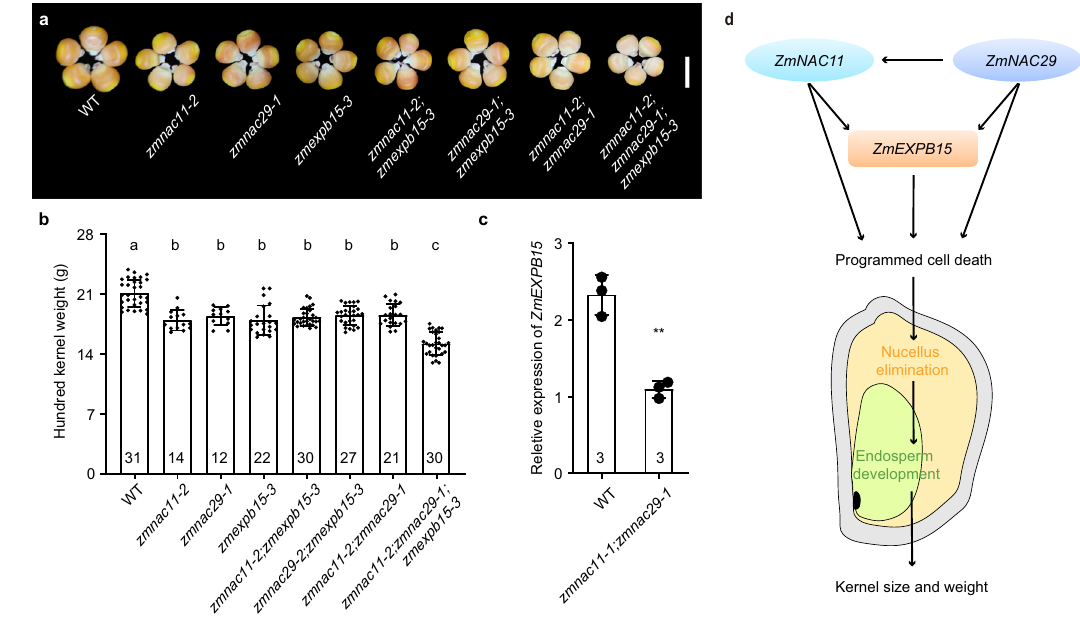
Fig. 7 | ZmEXPB15 may act in a common pathway with ZmNAC11 and ZmNAC29 to regulate kernel size and weight. a Comparison of the mature kernels of wild type(WT)anddifferentmutationcombinations, zmnac11-2 , zmnac29-1 , zmexpb15-3 (KO3), zmnac11-2;zmexpb15-3 , zmnac29-1;zmexpb15-3 , zmnac11-2;zmnac29-1 and zmnac11-2;zmnac29-1;zmexpb15-3 in C01 background. Scale bar=1cm. b QuantitativeanalysisofHKWofWT, zmnac11-2 , zmnac29-1 , zmexpb15-3 , zmnac11- 2;zmexpb15-3 , zmnac29-1;zmexpb15-3 , zmnac11-2;zmnac29-1 and zmnac11- 2;zmnac29-1;zmexpb15-3 .Valueismeans±s.d.TukeyHSDtestisusedandstatistical differences ( P <0.05, one-sided) are indicated by different letters. Number on the bottom of each column is the sample size. c qRT-PCR analysis of ZmEXPB15 in